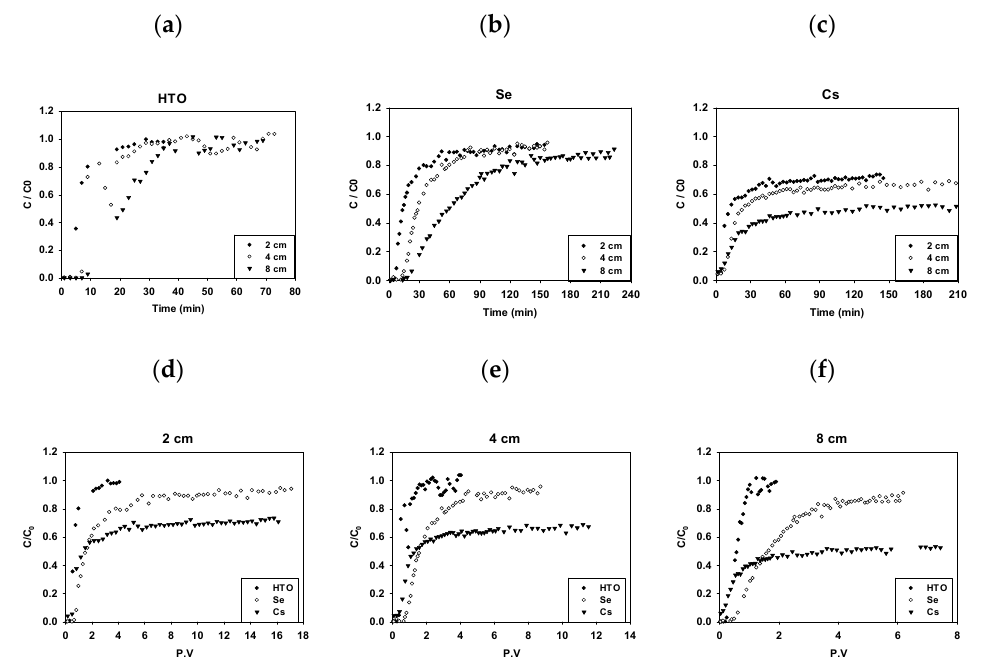
Figure 3. The experimental breakthroughs in different lengths. ( a ) HTO; ( b ) Se(IV); ( c ) Cs; ( d ) 2 cm; ( e ) 4 cm; ( f ) 8 cm.